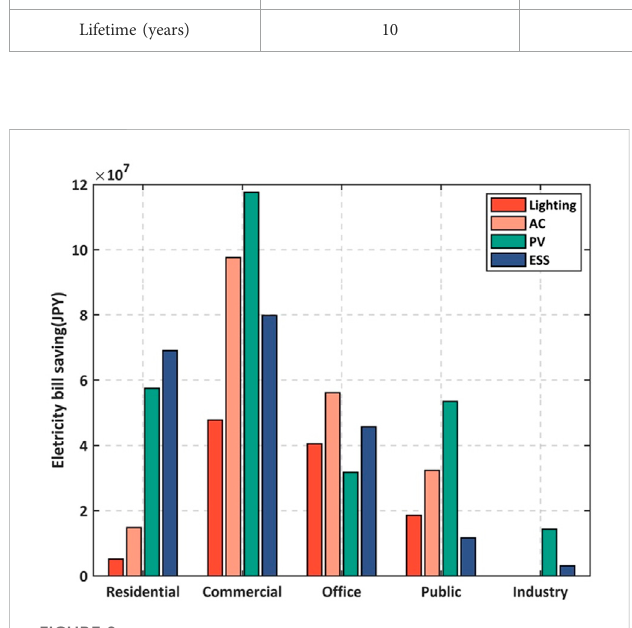
FIGURE 9 Annual electricity bill saving of different